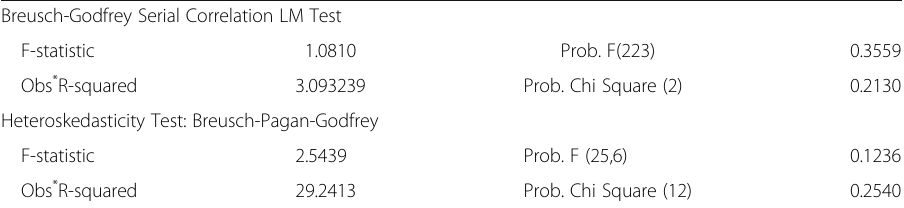
Table 6 Serial Correlation and Heteroskedasticity Test Breusch-Godfrey Serial Correlation LM Test F-statistic 1.0810 Prob. F(223) 0.3559 Obs * R-squared 3.093239 0.2130 Heteroskedasticity Test: Breusch-Pagan-Godfrey